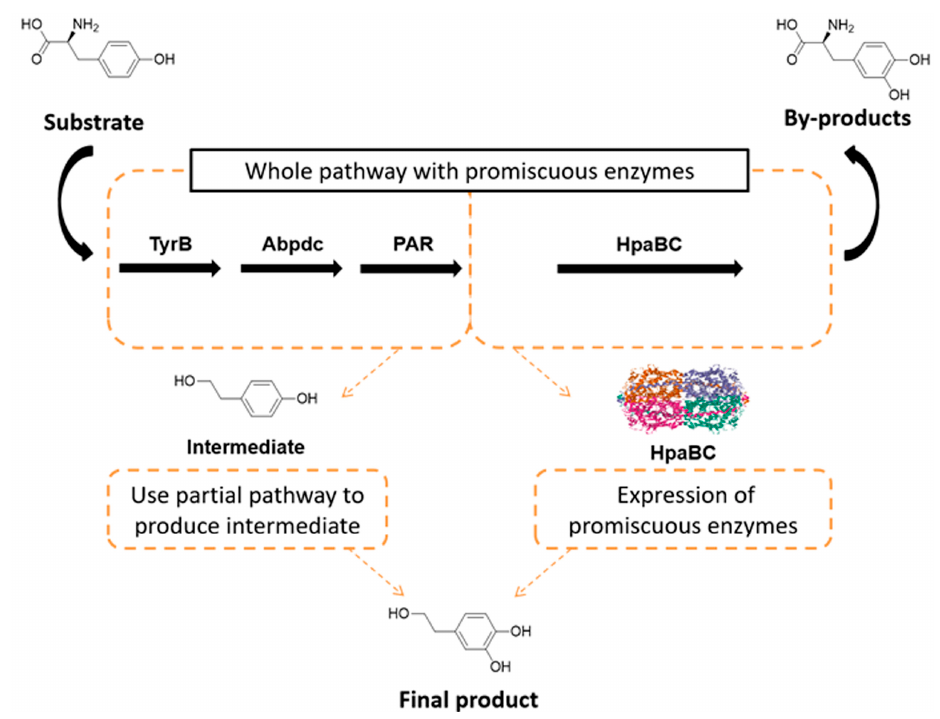
Figure 6. Diagram of the two-stage microbial consortia catalysis strategy.